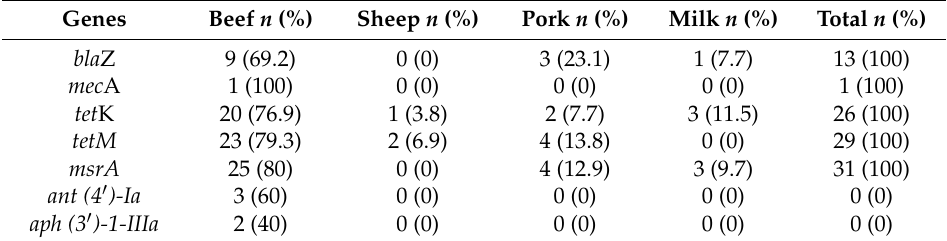
Table 4. Resistant genes detected from Staphylococcus aureus isolated from the Eastern Cape